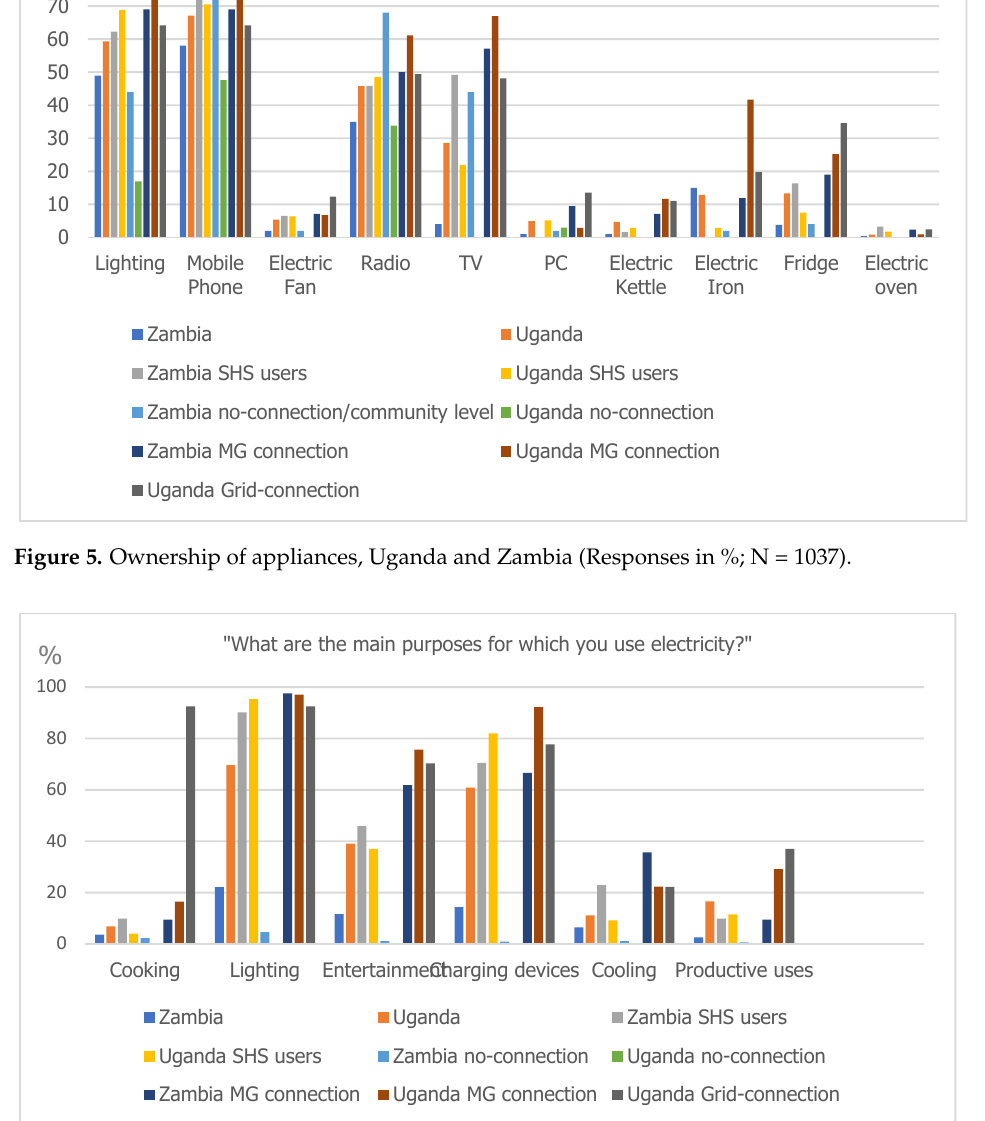
Figure 6. Energy usage patterns; Consumer Groups in Uganda and Zambia (Responses in %; N = 1037).